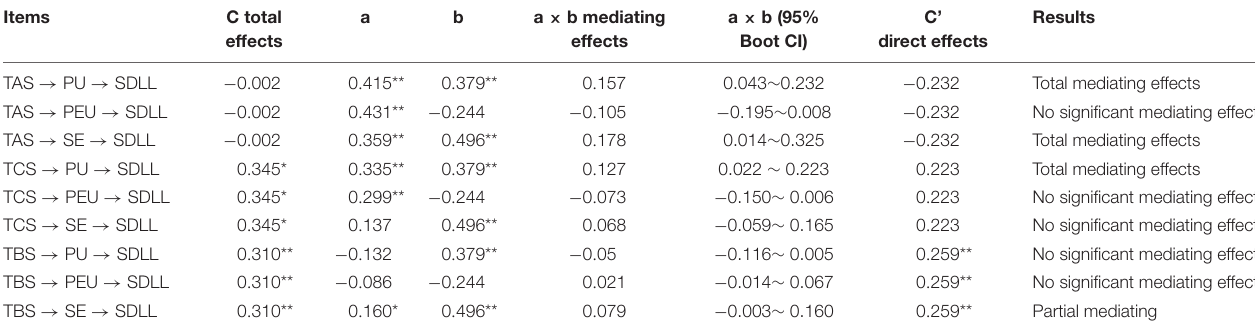
TABLE 6 | The mediating